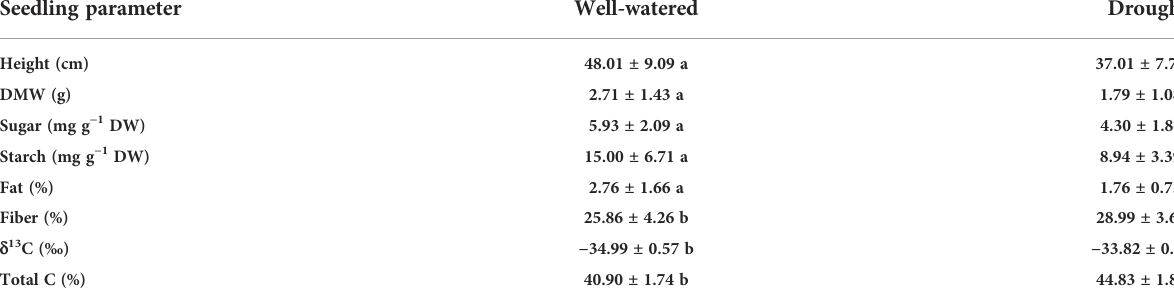
TABLE 2 Drought effect on growth, DM accumulation, carbohydrate metabolism, quality establishment, and C in alfalfa ( Medicago sativa L.) seedlings. Seedling parameter